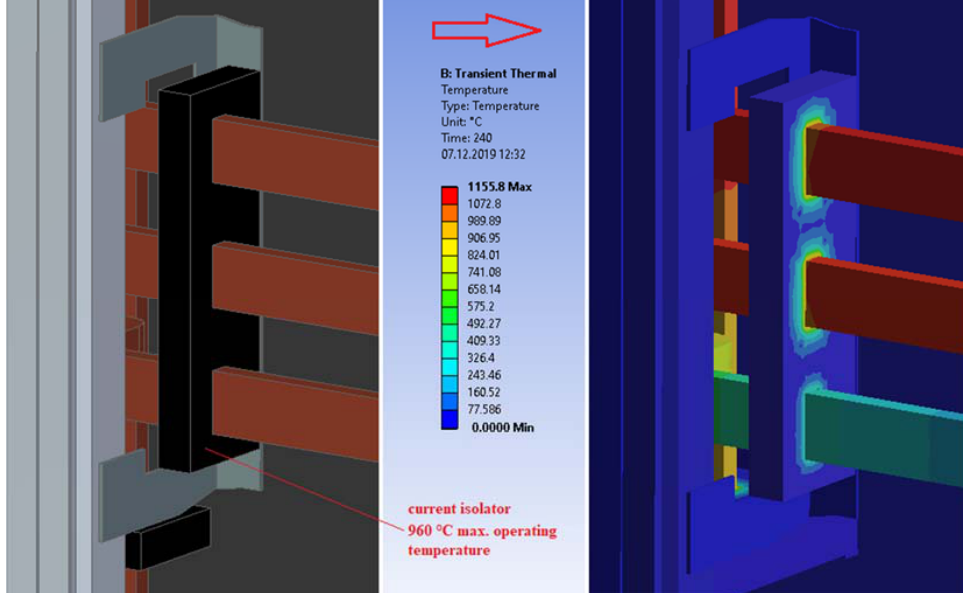
Figure 13. The temperature distribution in busbars and insulators during 240 s simulation in short-circuit conditions.